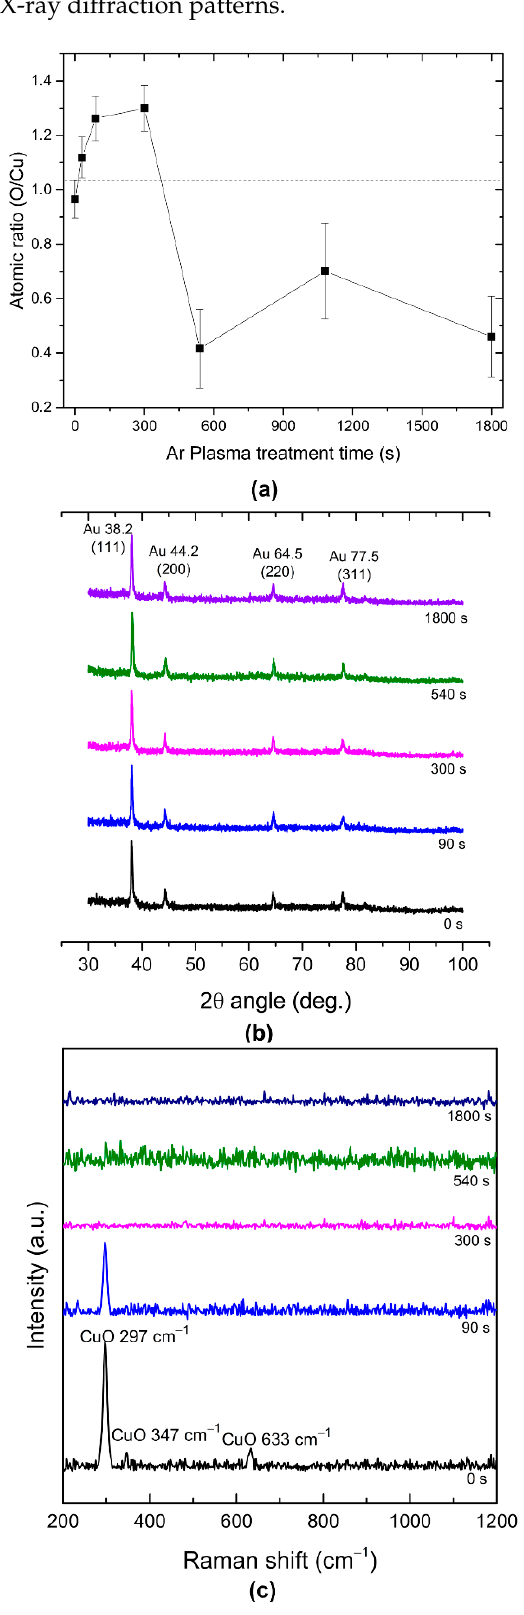
Figure 2. ( a ) O/Cu atomic ratio measured by RBS, ( b ) X-ray diffraction patterns, and ( c ) Raman spectra of the Au:CuO thin films as a function of Ar plasma treatment time.